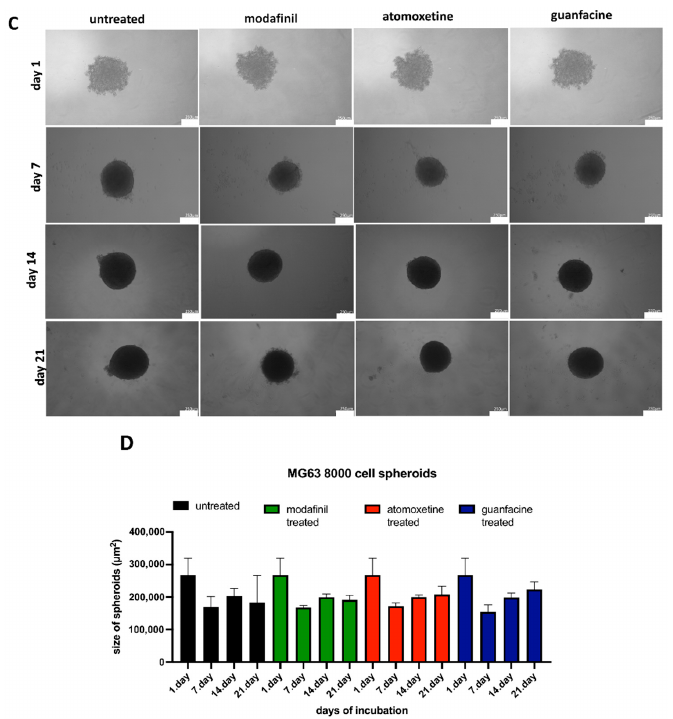
Figure 2. Effect of starting cell number after administration of untreated modafinil (11.2 µg/mL), atomoxetine (0.9 µg/mL) and guanfacine (17.7 ng/mL) on spheroid size and morphology of MG63 (5000 cells) ( A , B ) and MG63 (8000 cells) ( C , D ). Spheroids were cultured for 21 days. Phase- contrast images of spheroids were taken at day 7, 14 and 21. Shown are means of spheroid size ± SD of three independent experiments with six biological replicates. Densitometric quantification of spheroid size was calculated by ImageJ software. Significance in difference between the groups was deter- mined by ANOVA followed by Tukey’s post hoc test. Scale bar 250 µm. 3.3. Analysis of the Spheroid size of 5000/8000-cell hMSC Spheroids Drug-treated hMSC spheroids showed no significant difference in terms of spheroid size compared to untreated hMSC spheroids (Figure 3A–D). Atomoxetine-treated hMSC spheroids with starting cell count of 8000 showed a significantly bigger spheroid than untreated hMSC spheroids.